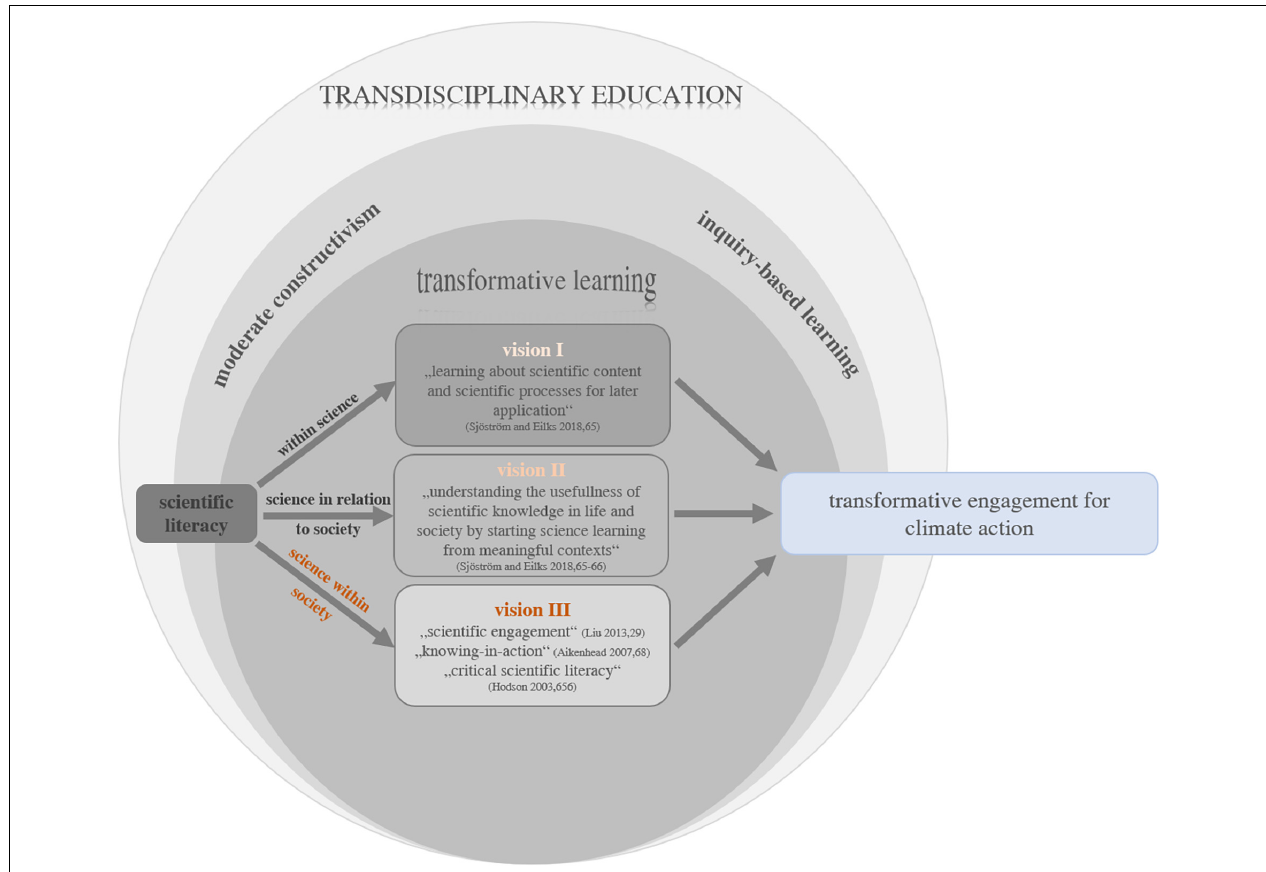
FIGURE 2 | Concept of TE (source: own